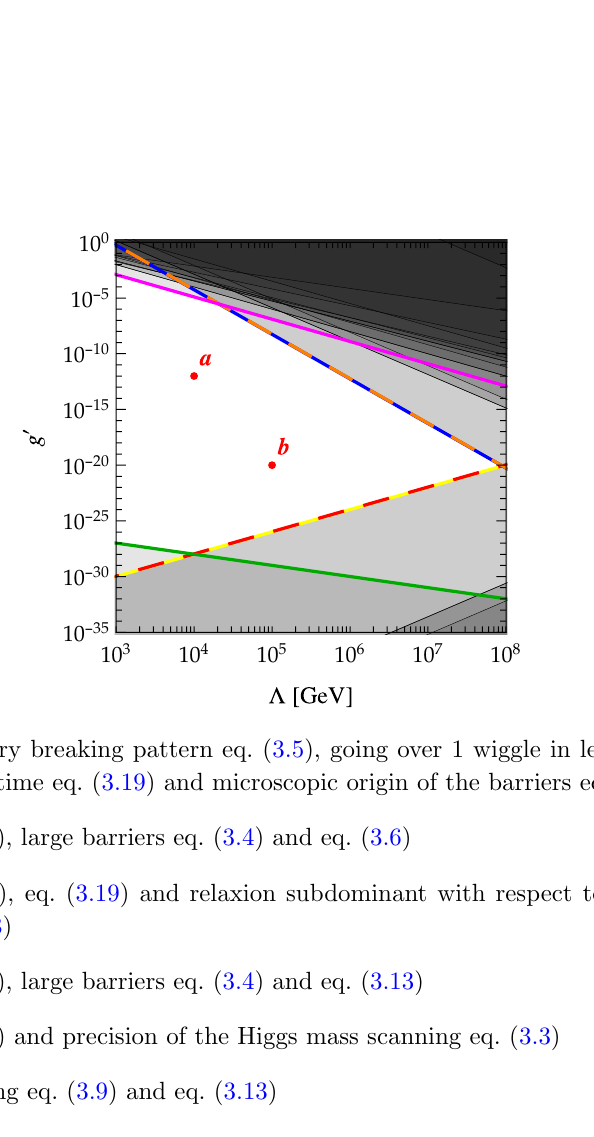
Figure 15 . Details of the origin of the constraints delimitating the red region presented in sec- tion 3.1 and (cid:12)gure 2 corresponding to the case where relaxation happens through Higgs-dependent barriers, during a stage of in(cid:13)ation, where the relaxion is a subdominant component of the energy density of the universe and where the relaxion stops because of large barriers .